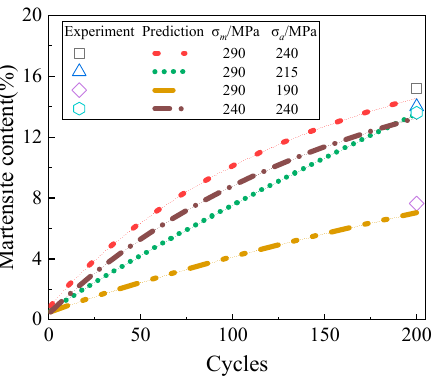
Figure 11. Martensite content prediction under different loading conditions by the proposed model.